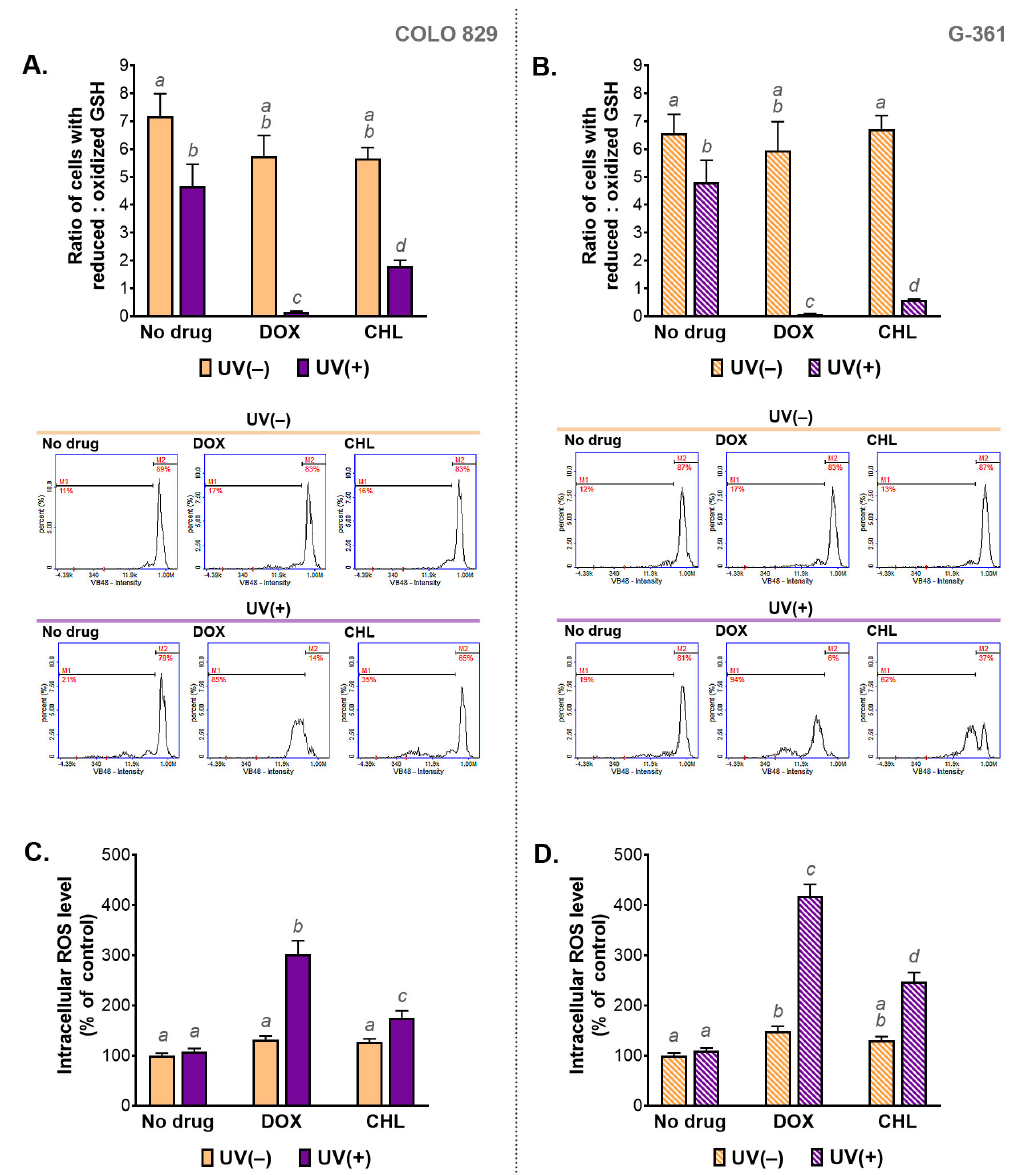
Figure 5. The analysis of the intracellular level of thiols ( A , B ) and reactive oxygen species ( C , D ) in melanoma cells treated with doxycycline and chlortetracycline and irradiated with UVA. Bar graphs present mean values ± SD. Included histograms are representative results of cytometric analysis of thiols. Using different letters to show statistical